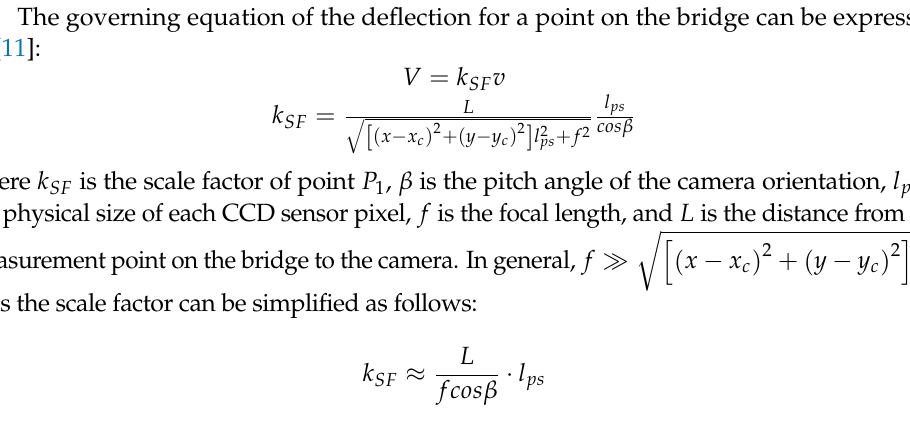
Figure 3. Schematic of the single-point deflection measurement.